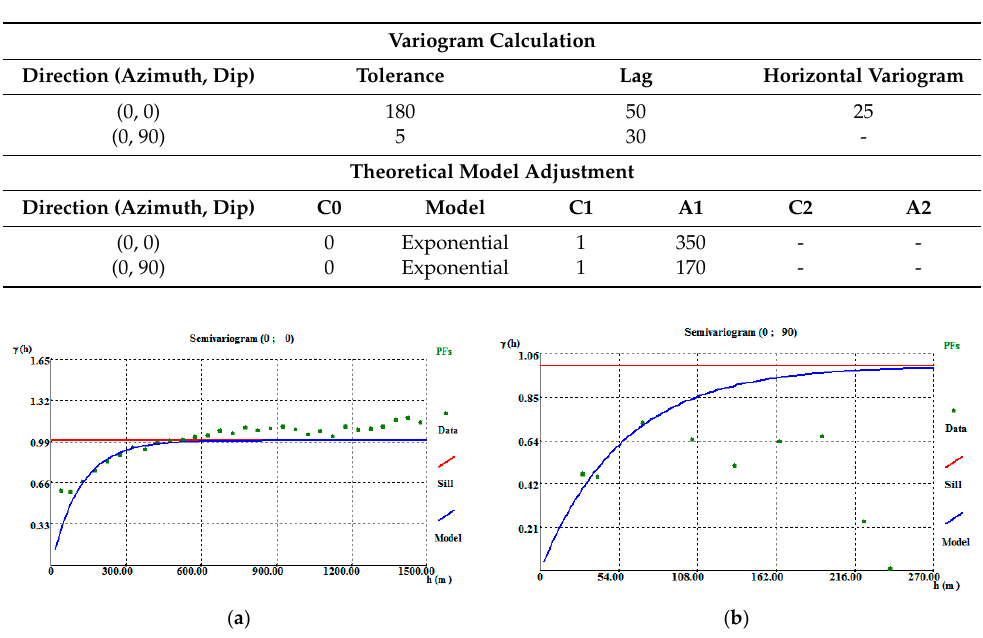
Figure A6. Borehole VP omnidirectional variograms: ( a ) borehole data regularization performed on a 10 m × 10 m × 10 m grid; ( b ) borehole data regularization performed on a 20 m × 20 m × 20 m grid. Table A7. Calculation and adjustment parameters for borehole VP variograms.